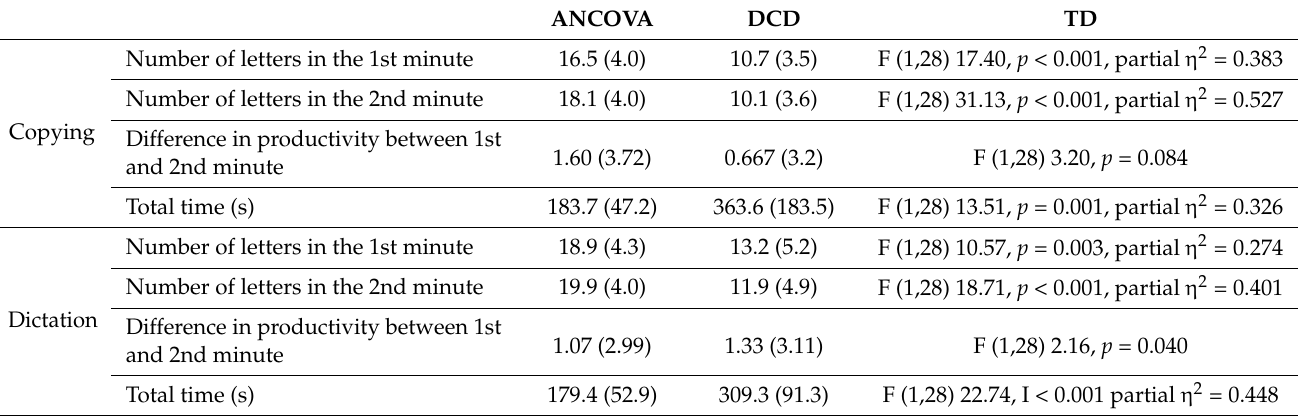
Table 3. Handwriting productivity and speed. Data are presented as mean and standard deviation in